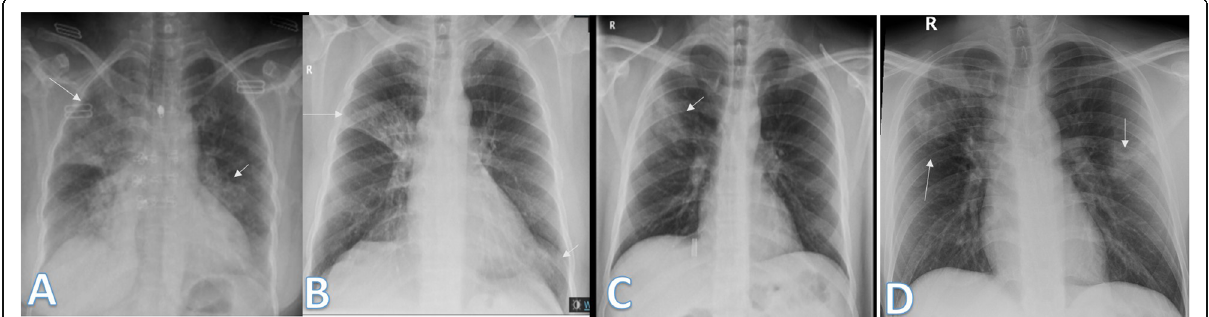
Fig. 4 Four different patients with positive COVID-19. a 45-year female was complaining of fever and cough. Initial chest X-ray showed bilateral lower zonal air space consolidation opacities with upper zonal predominance on the right side (long arrow) and perihilar pattern on the left side. The severity score was 2 for the right lung and 1 on the left lung, so TSS was 3. b 60-year male was complaining of fever. Initial chest X-ray showed bilateral air space consolidation opacities with upper zonal predominance on the right side (long arrow) and at the paracardiac area on the left side (short arrow). The severity score was 1 for each lung so, TSS was 2. c 23-year asymptomatic male. Initial chest X-ray showed right upper zonal air space consolidation opacity (arrow). The total severity score was 1. d 28-year male patient presented with cough, on initial X-ray showed right upper zonal (long arrow) and left midzonal (short arrow) air space consolidation opacities; the severity score was 1 for each lung, so TSS was